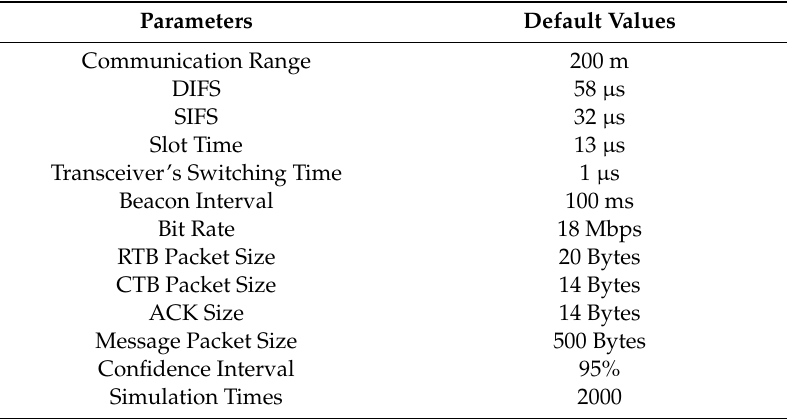
Table 1. Major communication parameters.